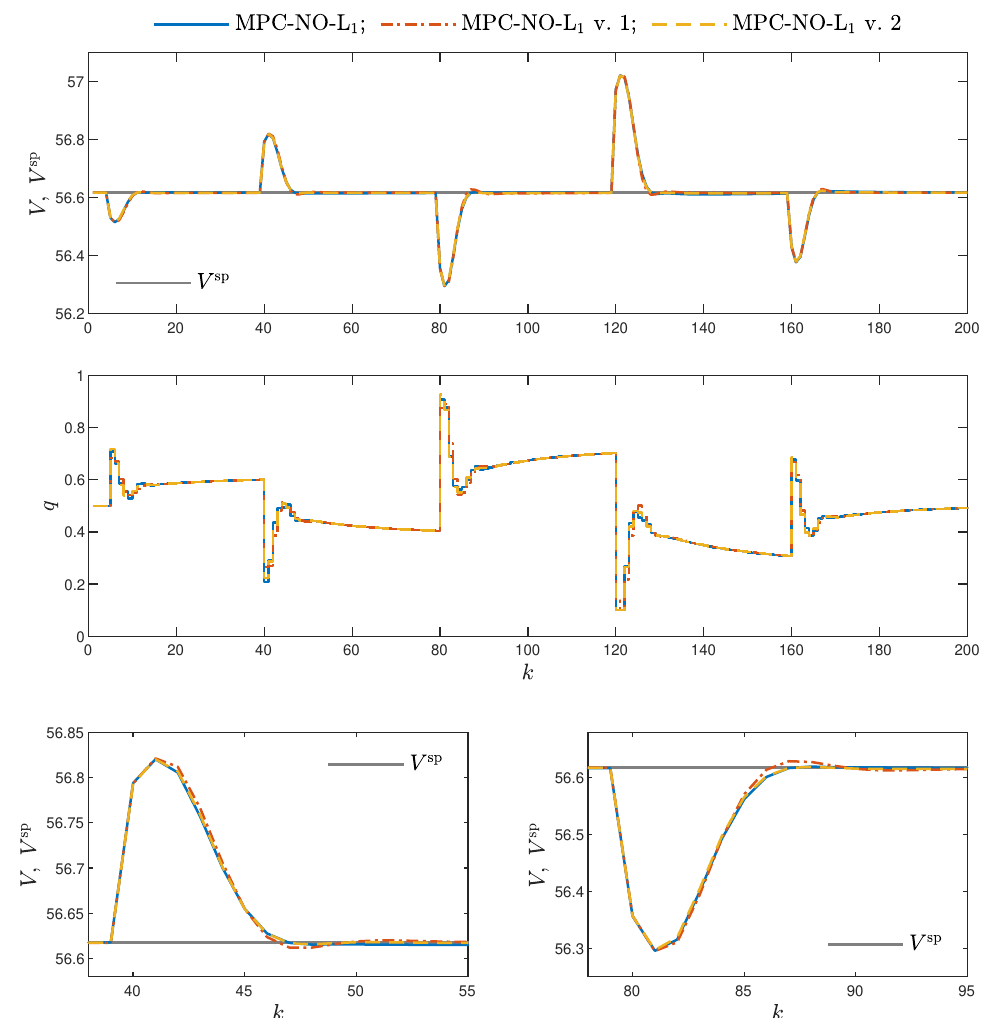
Figure 4. Simulation results: the MPC-NO-L 1 , MPC-NO-L 1 v. 1 and MPC-NO-L 1 v. 2